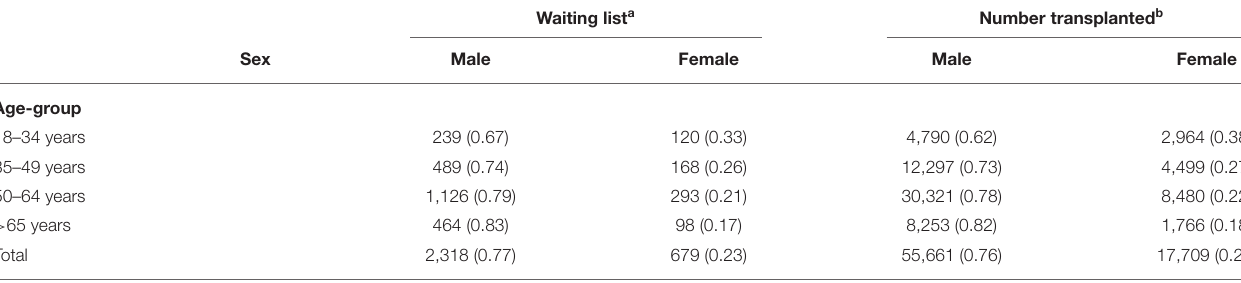
TABLE 1 | Heart transplant waiting list and allocation according to sex and age-groups.